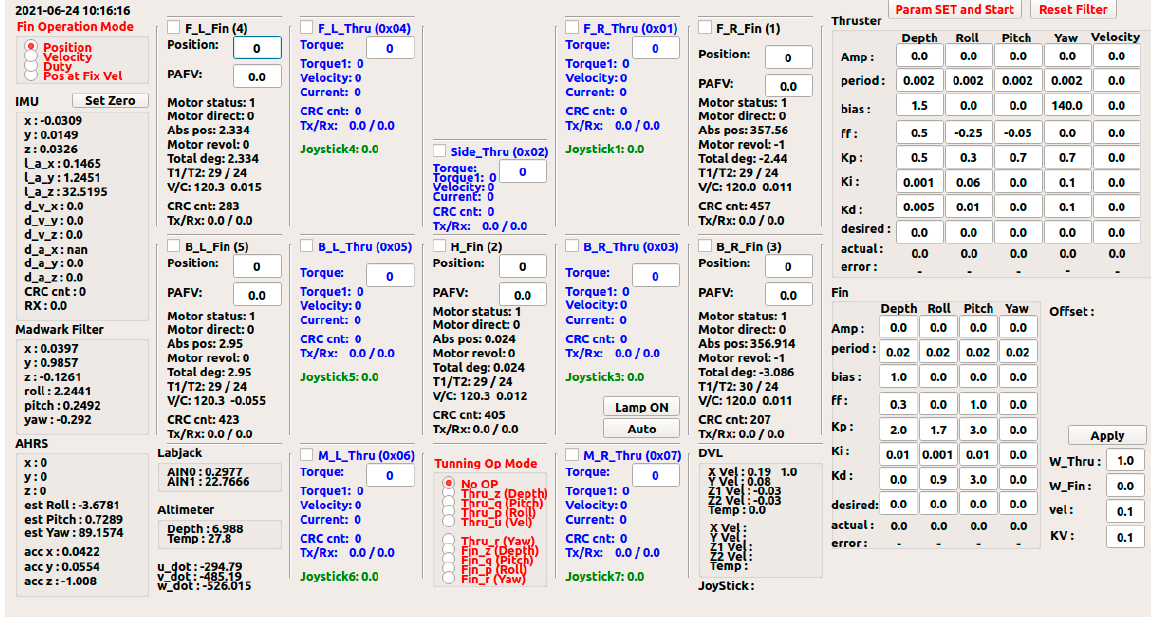
Figure 6. TUP monitoring software .